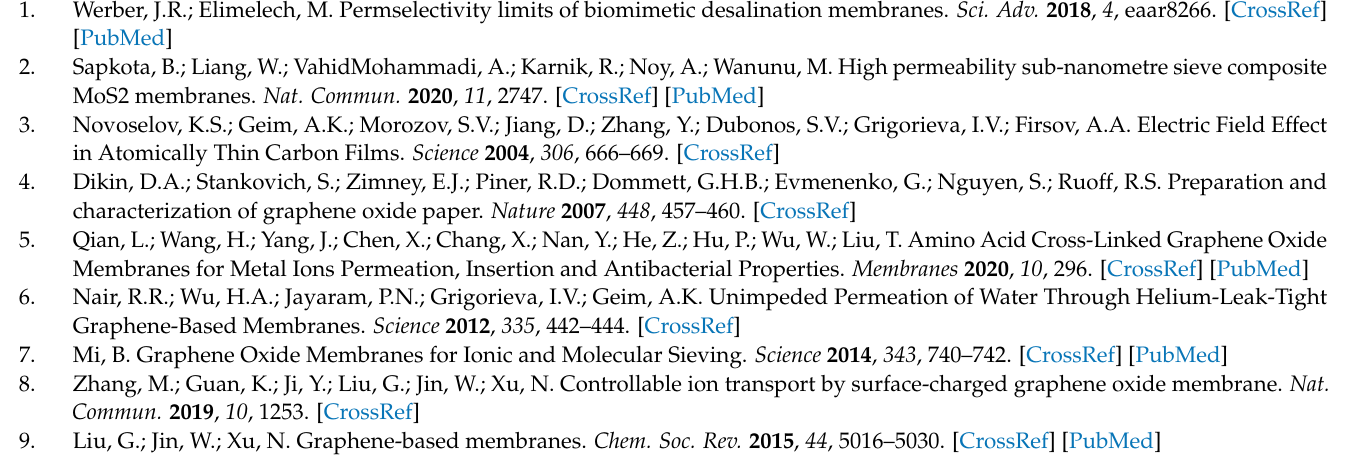
Figure S1: Cross-sectional SEM images of (a) GO membrane, (b) WRGO membrane, (c) MRGO membrane, and (d) FRGO membrane. Figure S2: Surface SEM images of (a) GO membrane, (b) WRGO membrane, (c) MRGO membrane, and (d) FRGO membrane. Figure S3: XPS spectra of (a) GO membrane, (b) WRGO membrane, (c) MRGO membrane, and (d) FRGO membrane over a wide scanning range. Figure S4: FTIR spectra of GO membrane, WRGO membrane, MRGO membrane, and FRGO membrane. Figure S5: Zeta potential analysis of GO membrane, WRGO membrane, MRGO membrane, and FRGO membrane. Figure S6: Photograph of a two-chamber diffusion cell. The H-type cell consists of feed and permeate sides; the membrane is located between them. Table S1: Comparison with other GO-based membranes. Figure S7: The long term of ion permeation rates through GO membrane, WRGO membrane, MRGO membrane, and FRGO membrane. Figure S8: The effect of ions concentrations in the draw solution on membrane permeability. Figure S9: The Mg 2+ ion permeation rates through GO membrane, WRGO membrane, MRGO membrane, and FRGO